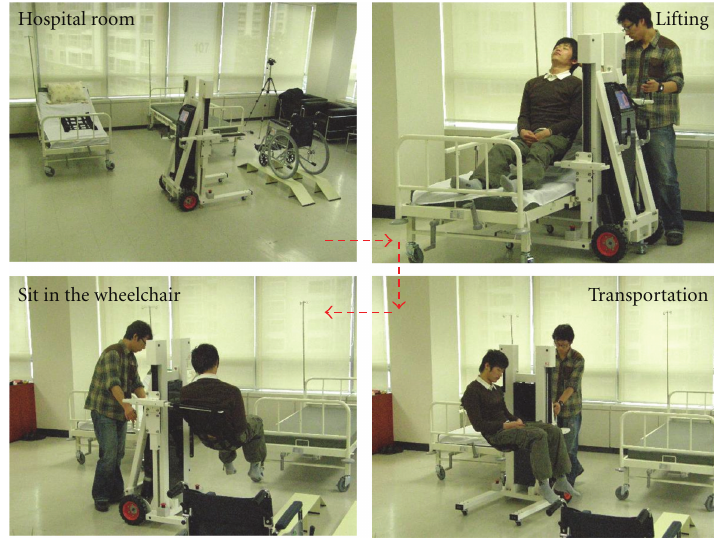
Figure 17: The transportation process.